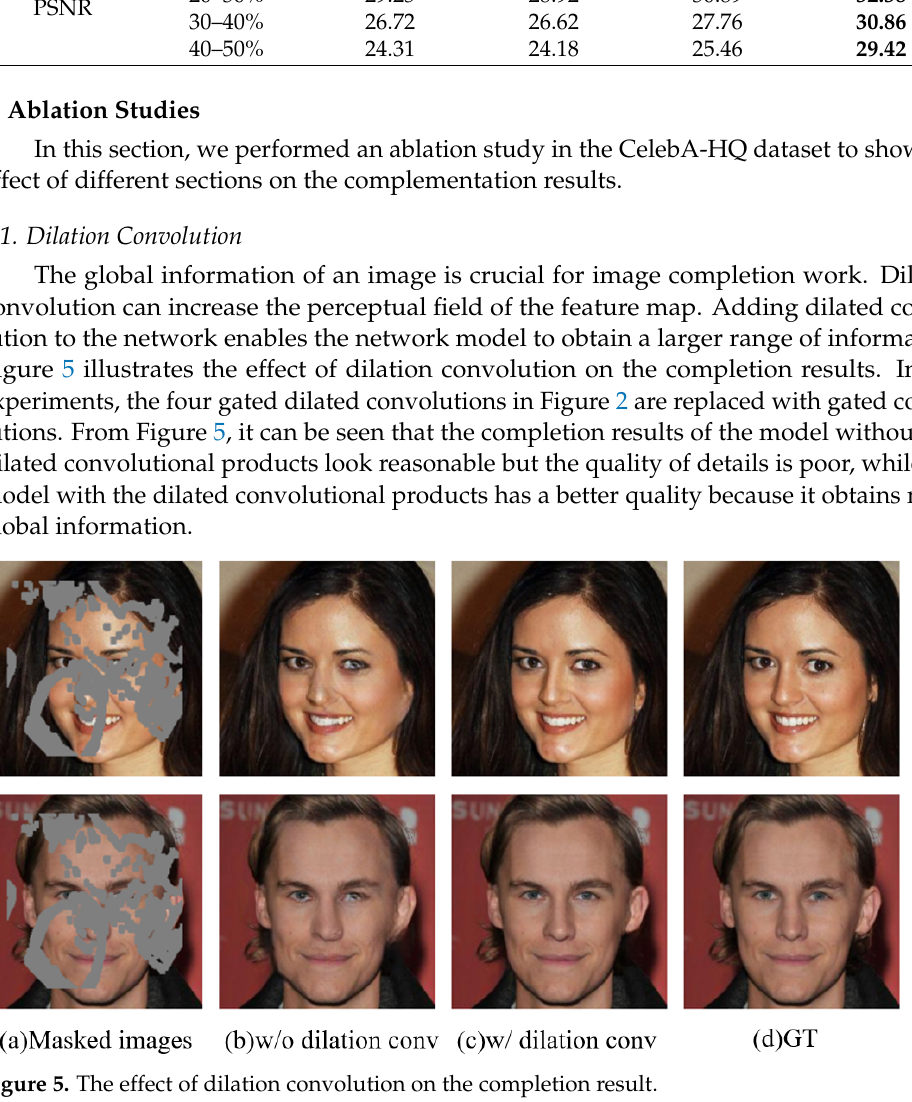
Figure 5. The effect of dilation convolution on the completion